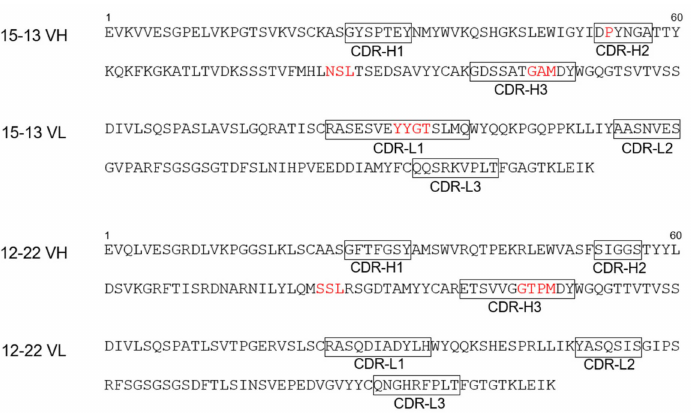
Figure 1. Sequence analysis of antibodies. The amino acid sequence of the VH and VL domains of 15–13 and 12–22 mAbs. CDRs are enclosed in a square. Red letters indicate the insertion of amino acid